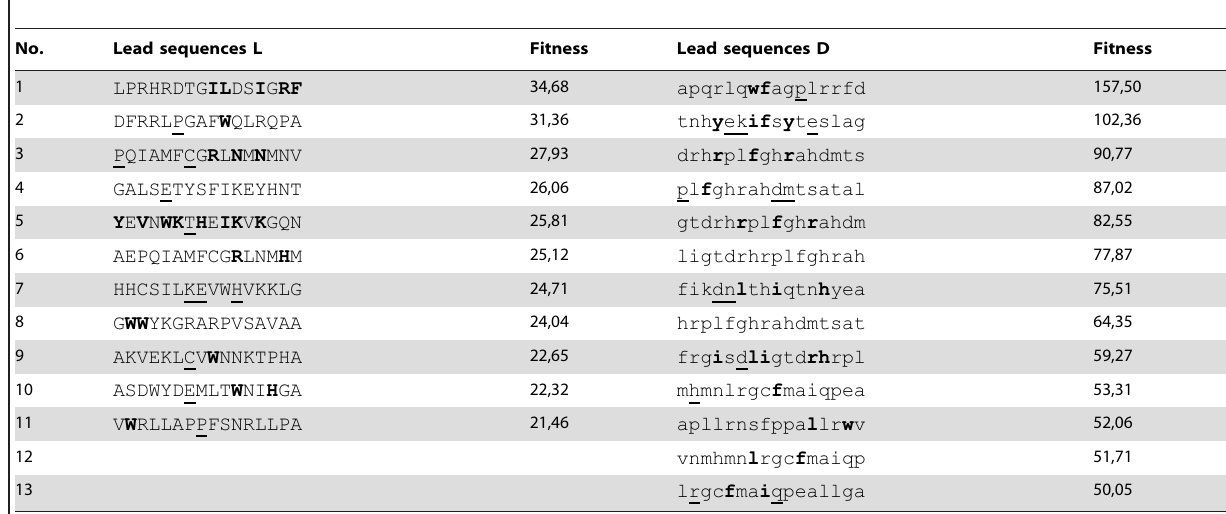
Fitness values correspond to fluorescence intensities obtained in a solid-phase binding assay with lysoG M1 /DY650-conjugate (arbitrary units) and reflect the probe- binding strength of each peptide. Highlighted amino acids were identified in ‘‘alanine walk’’ experiments as beneficial (boldface) or detrimental (underlined) for binding.